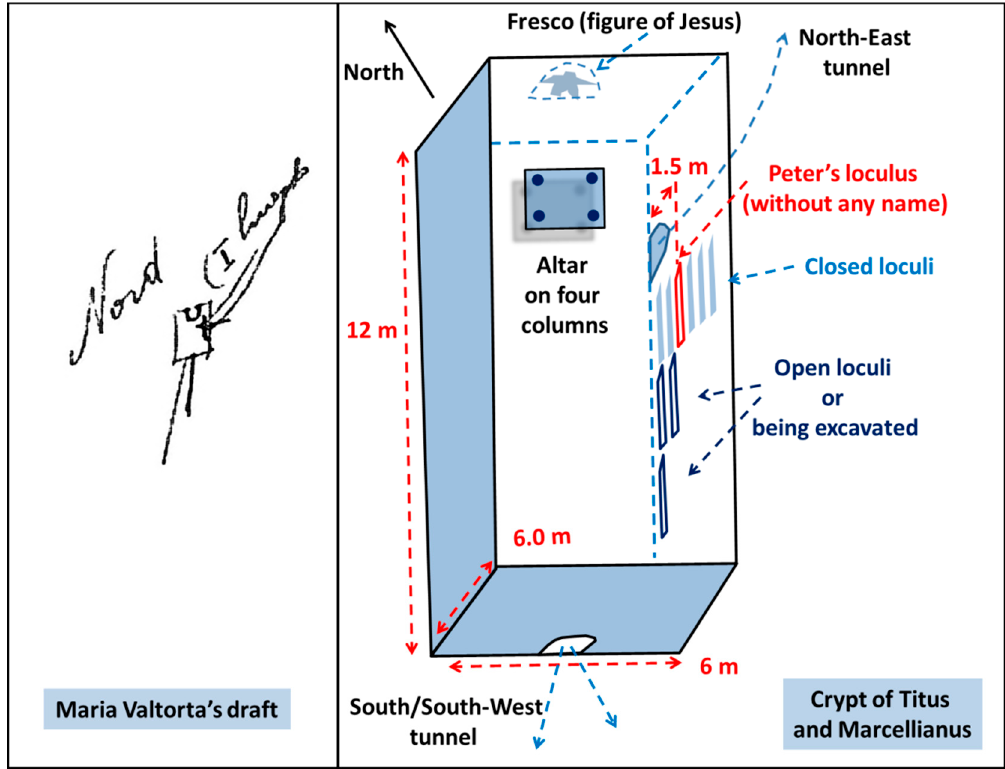
Figure A1. Scheme of the crypt with the first Peter’s burial site, according to the MWs of Maria Valtorta. On the left a sketch of the crypt’s orientation, with respect to the north cardinal point, reported by Maria Valtorta [11], p. 34, with the inscriptions “Nord” (North) and “I luogo” (first site), the position of the altar “U” and the niche containing Peter’s relics indicated by an “x”, near the entrance to the tunnel that goes towards North-East.